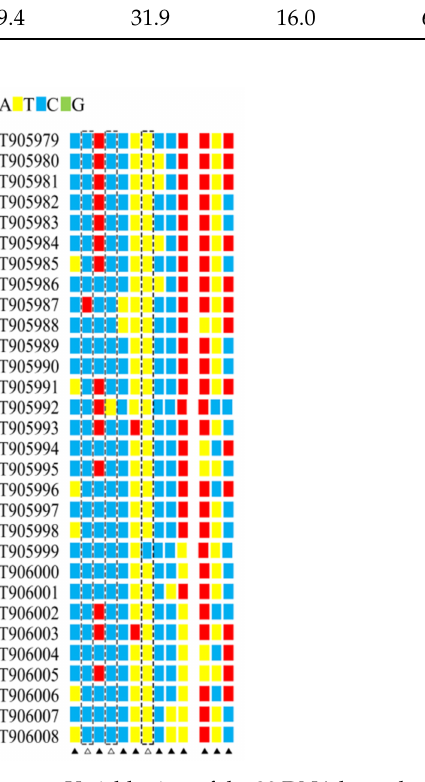
Figure 7. Variable sites of the 30 DNA barcode sequences. ∆ Singleton sites (cid:78) Parsim informative sites. The original CO1 gene DNA barcode fragment represents a single nucleotide